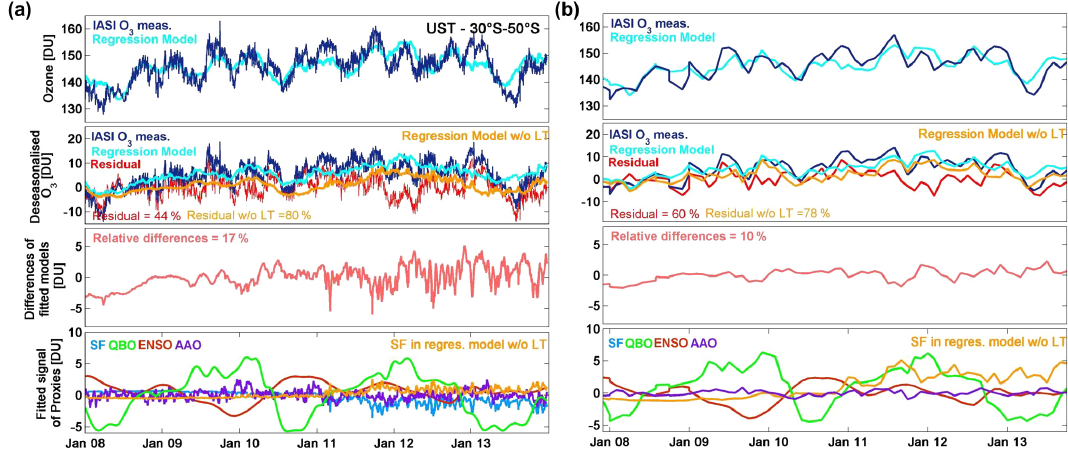
Figure 9. Daily (a) and monthly (b) time series of O 3 measurements and of the fitted regression model in the UST for the 30–50 ◦ S latitude band (top row), of the deseasonalised O 3 (second row), of the difference of the fitted models with and without the linear term (third row) and of the fitted signal of proxies (cid:2) regression_coefficient × proxy (cid:3) : SF (blue), QBO (QBO 10 + QBO 30 ; green), ENSO (red) and AAO (purple) (bottom) (given in DU). The averaged residuals relative to the deseasonalised IASI time series are also indicated